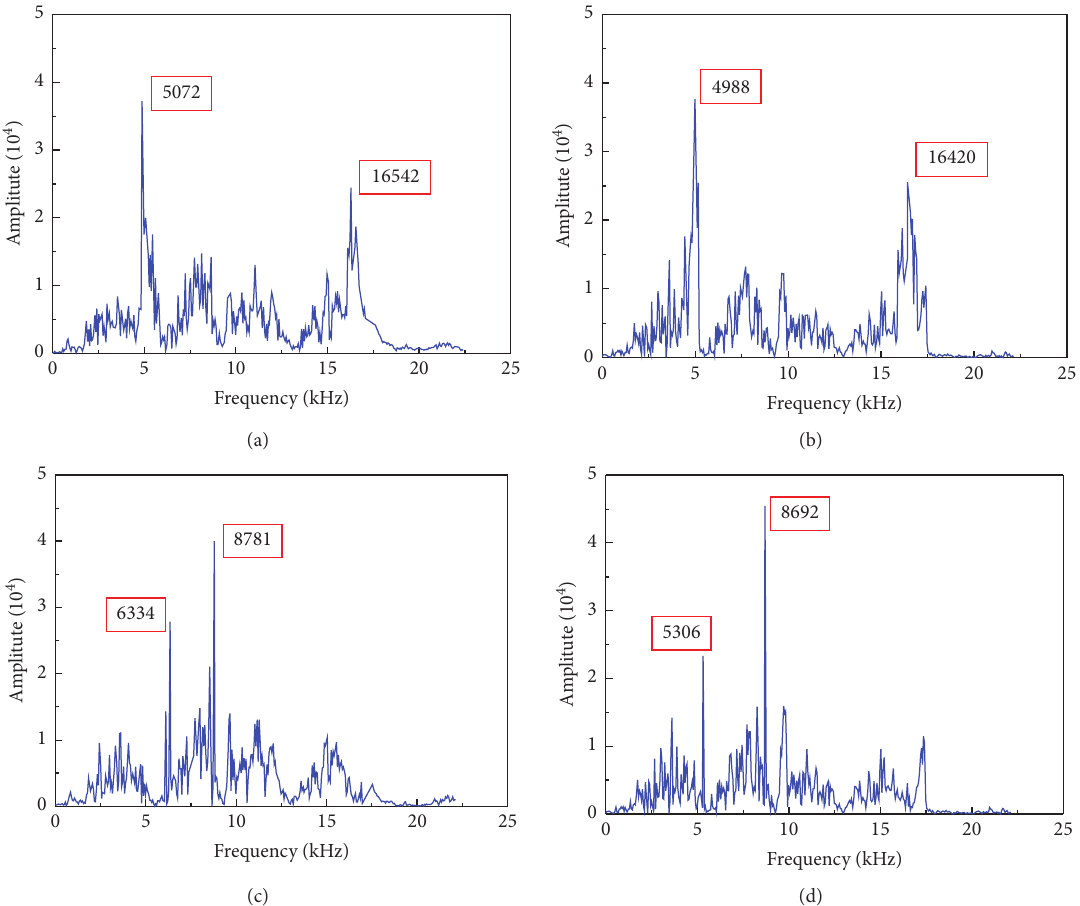
Figure 4: Parts of the spectrogram. (a) 3-spectrogram of metal bellows; (b) 4-spectrogram of metal bellows; (c) 7-spectrogram of metal bellows; (d) 9-spectrogram of metal